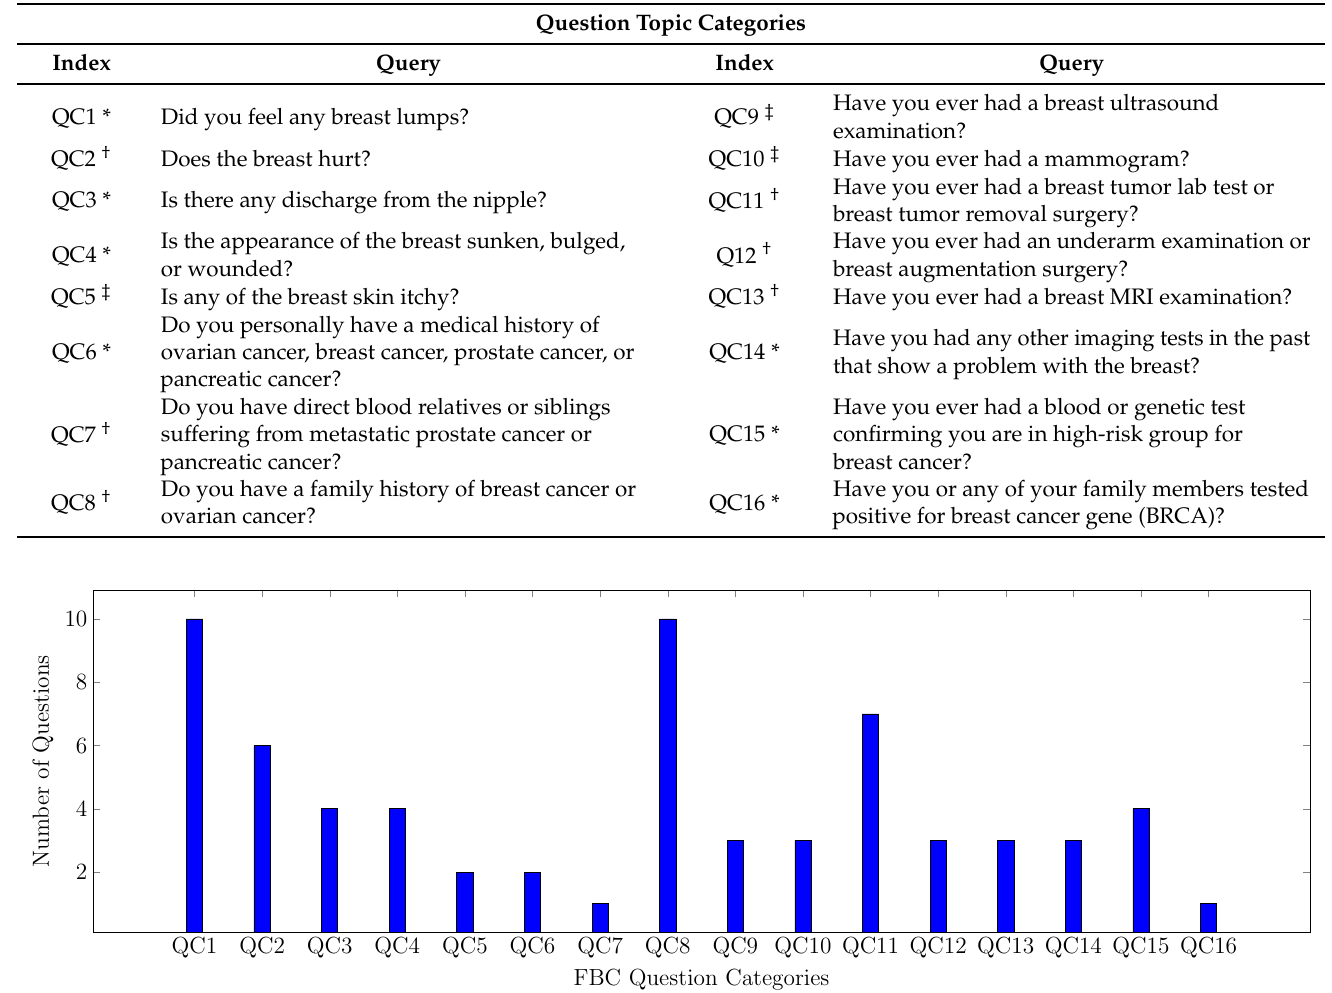
Table 1. The 16 major question categories (QC) structured in SAC’s knowledge base for chat assessment of users’ FBC symptoms. Positive user responses to SAC’s queries with * imply serious FBC symptoms, likewise, ‡ = moderate symptoms, while † = mild symptoms.